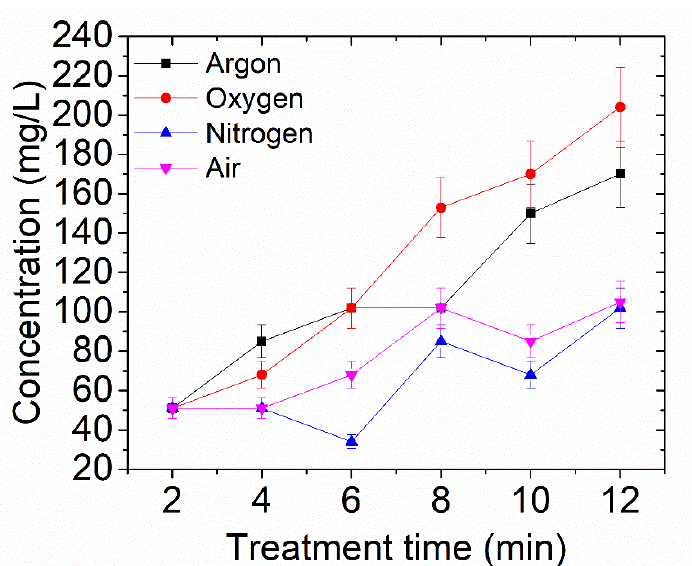
Figure 7. Measurement of the concentration of hydrogen peroxide as a function of treatment time with four gas feedings: argon, oxygen, nitrogen, and air. with four gas feedings: argon, oxygen, nitrogen, and